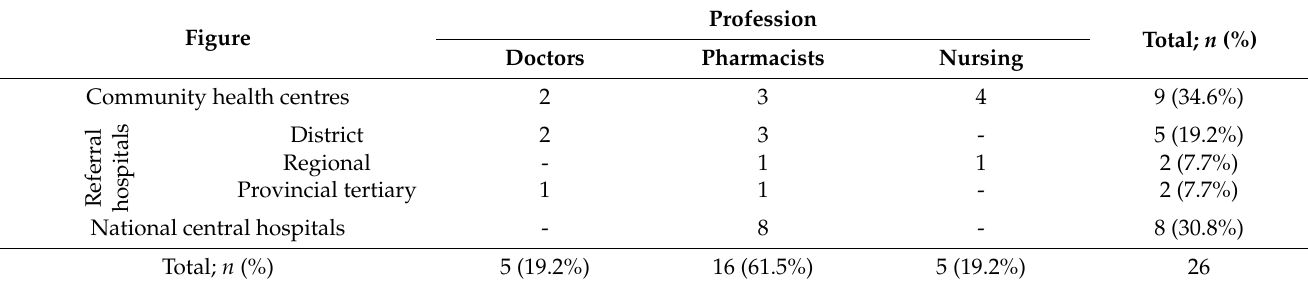
Table 1. Respondents distributed by profession and facility type ( n = 26) (Phase 1).